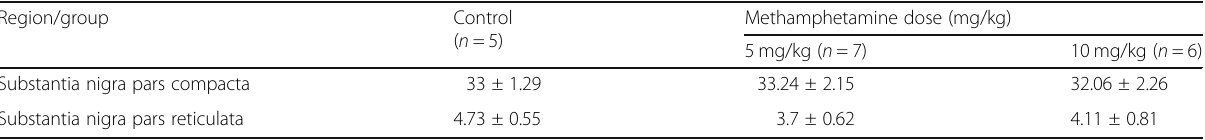
Table 1 Comparable tyrosine hydroxylase immunoreactive positive cell numbers in the control and methamphetamine (METH)- treated rats ’ substantia nigra